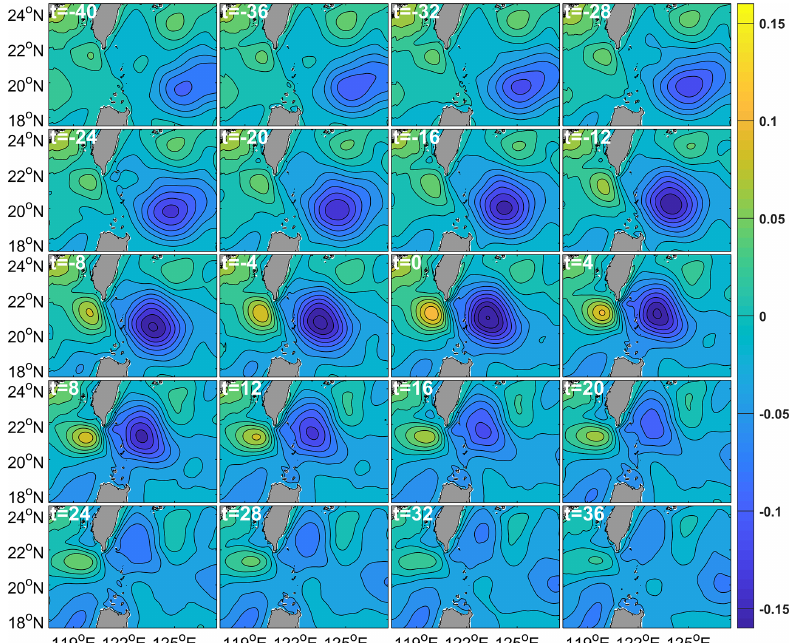
Figure 8. Evolution of CE mode of counter-rotating eddy pair in LS based on HYCOM data. Contours and shading both represent SSHA (units of m). SSHA interval is 0.02m. t in the top left-hand corner of each panel denotes the days before (negative value) or after (positive value) the CE mode of the counter-rotating eddy pair reached the maximum ( t = 0). t = 0 corresponds to time of Fig. 3b.